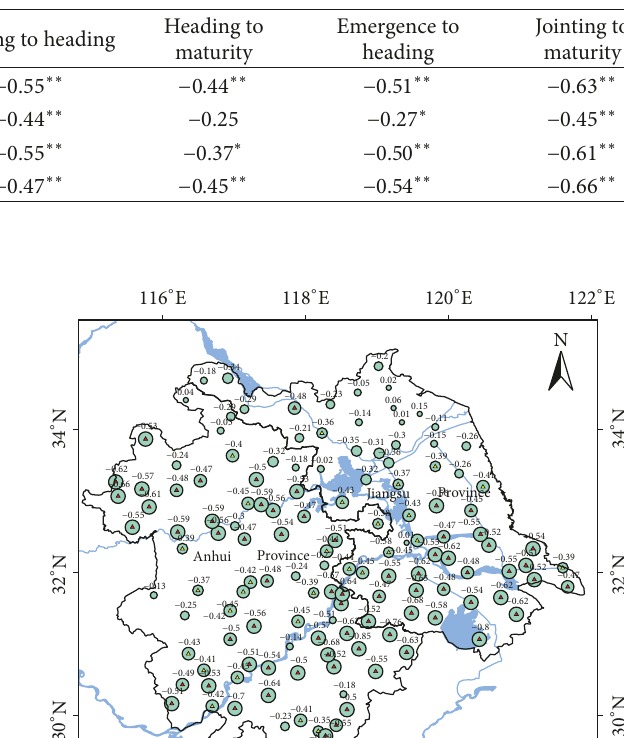
Table 1: Correlation analysis between the average relative meteorological yield and average PAP during different growth stages of winter wheat in each subregion.